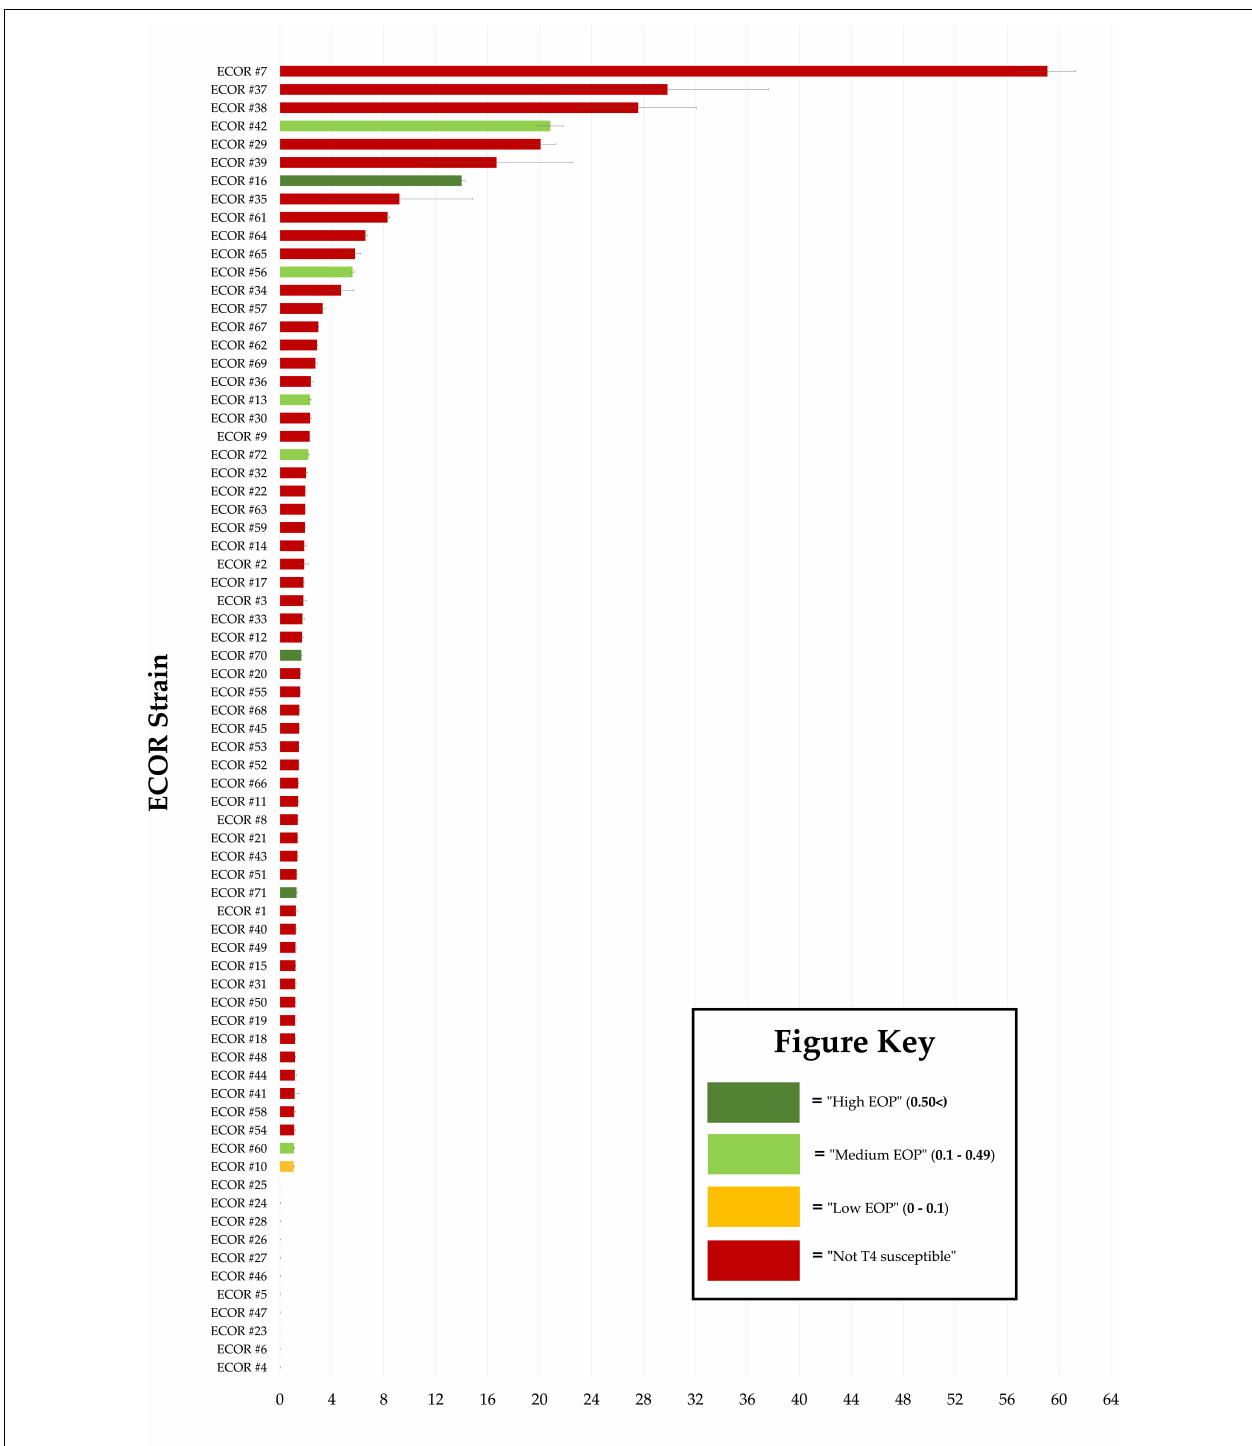
FIGURE 4 | Normalized and ranked bioluminescent output of “NLuc-LTF”-treated ECOR strains. The average bioluminescent output (measured in RLU) for each treated ECOR strain was normalized by dividing the mean Relative Luminescent Unit (RLU) of an ECOR strain by that of an on-plate control’s mean RLU (JW2203). Error bars represent the standard deviation of three normalized replicates. Efficiency of plating (EOP) calculations utilized the results of T4’s full plate plaque assay evaluations. Bar colors represent (red) non-permissive T4 strains, (dark green) permissive hosts with “High EOP” (0.5 < ) values, (light green) permissive hosts with “Medium EOP” (0.1–0.49) values, and (yellow) permissive hosts with “Low EOP” ( < 0.1) values.